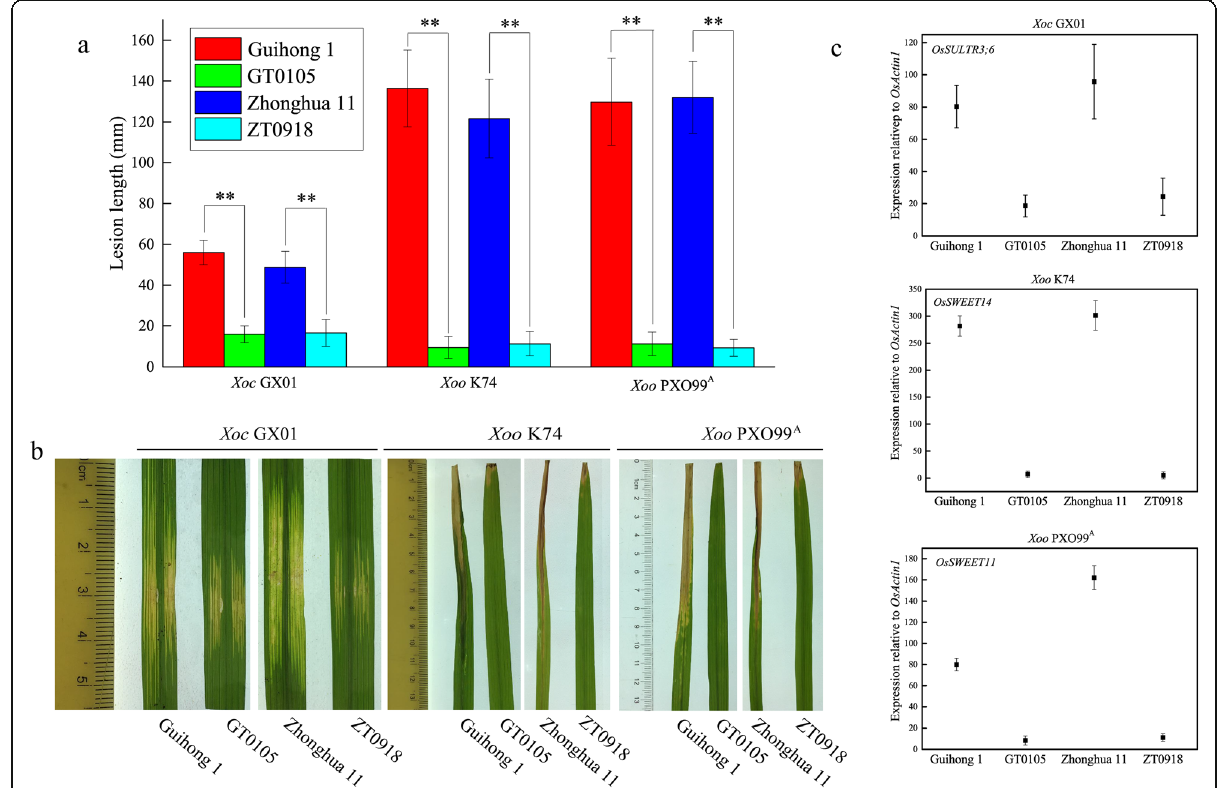
Fig. 2 Detection of disease resistance and qRT-PCR analysis of susceptibility genes in disease-resistant rice lines. a, Length analysis of disease lesions. The bars indicate the standard deviations; ** indicates a significant difference between the lesion lengths via the t -test ( P ≤ 0.01). b, Phenotypes of disease reactions in wild type rice varieties (Guihong 1 and Zhonghua 11) and edited rice lines (GT0105 and ZT0918) after inoculation with Xoc GX01, Xoo PXO99 A and Xoo K74. c, Relative expression levels of susceptibility genes in rice infected with Xoc GX01, Xoo K74 and Xoo PXO99 A ; the levels were determined via qRT-PCR. OsActin1 was used as an internal standardized